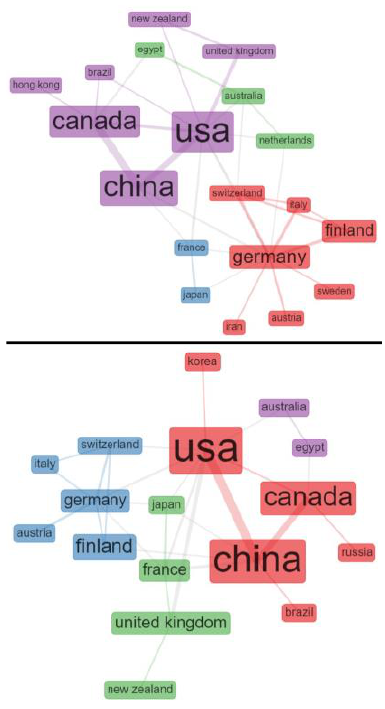
Figure 10 . Collaboration network by countries (Scopus at the top, WoS at the